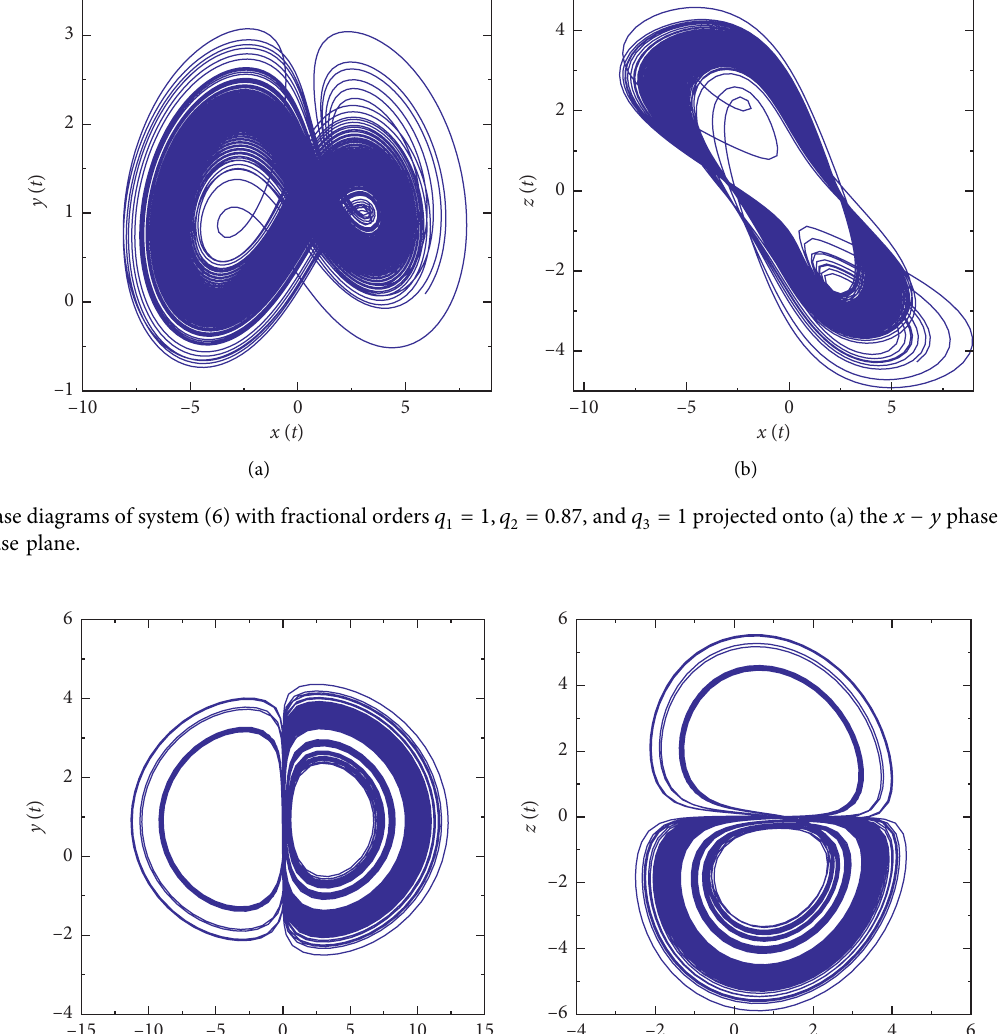
� 1 , q � 1, and q � 0 . 13 projected onto (a) the x − y phase plane and (b) 1 2 3